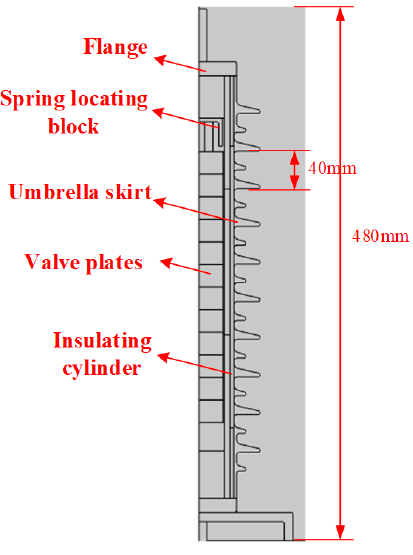
Figure 10. Arrester model.